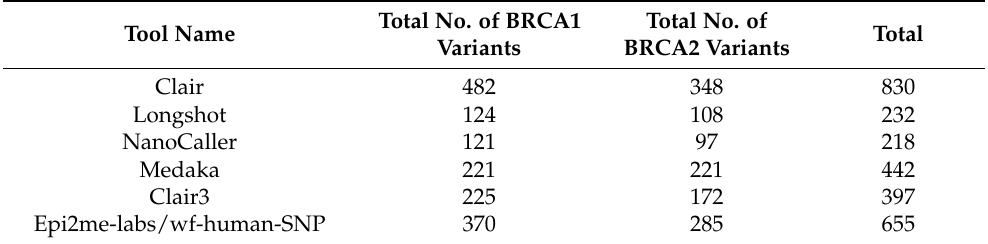
Table 3. The total no. of the output variants (SNPs, INDELs, and MNPs) of the six variant callers in comparison to both BRCA1 and BRCA2 genes in the